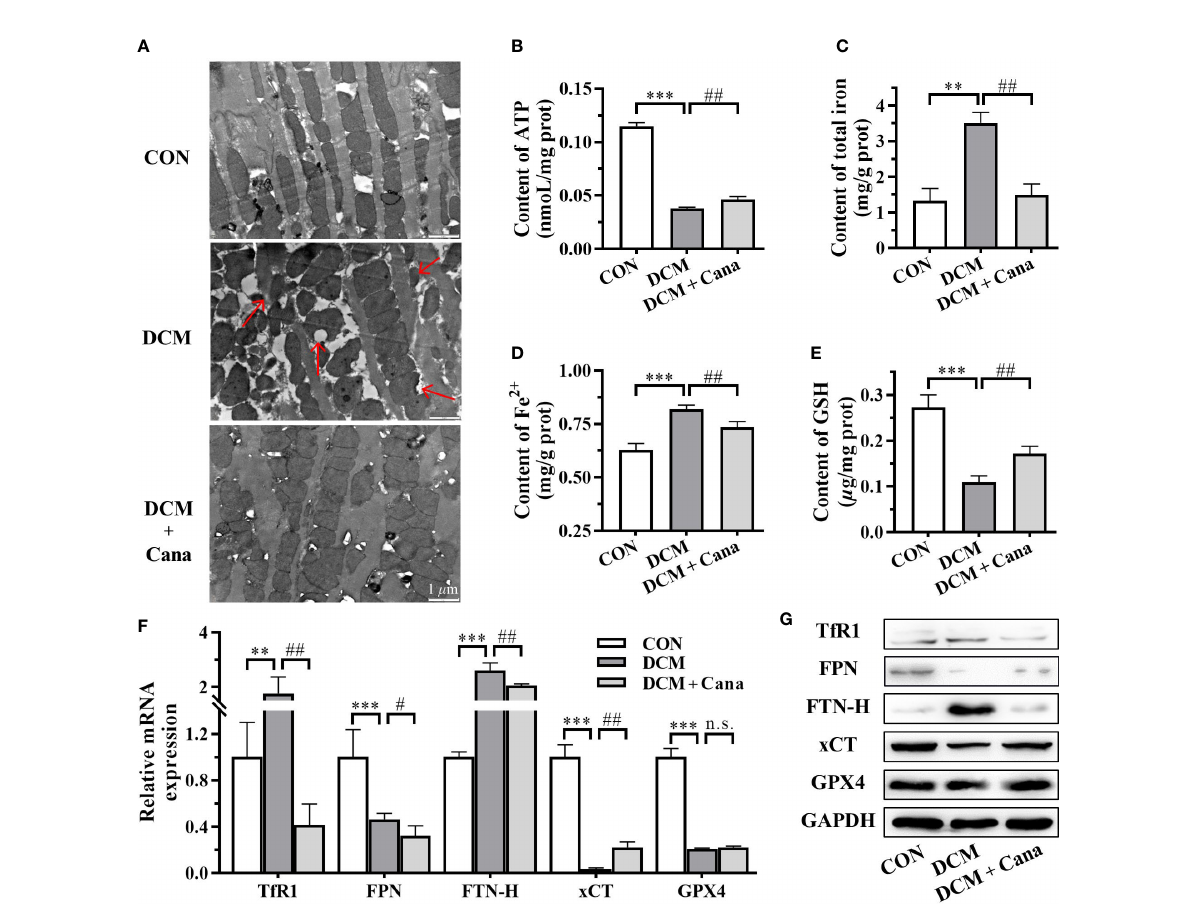
FIGURE 2 Canagli fl ozin inhibits mitochondrial damage and ferroptosis in diabetic mice. (A) Morphological and structural observation of mitochondria in myocardial tissues (Scale bar: 1 µ m). Contents of (B) ATP; (C) total iron; (D) Fe 2+ and (E) GSH in myocardial tissues. (F) Transcriptional level and (G) protein level of iron metabolism and ferroptosis related genes examined by qPCR and western blotting assay. ATP, adenosine triphosphate; GSH, glutathione; TfR1: transferrin receptor 1; FPN, ferroportin; FTN-H, ferritin heavy-chain; xCT, cystine-glutamate antiporter; GPX4, glutathione peroxidase 4; GAPDH, glyceraldehyde-3-phosphate dehydrogenase. (**: P<0.01; ***: P<0.001; compared with CON group; #: P<0.05; ##: P<0.01; compared with DCM group; n.s.: no signi fi